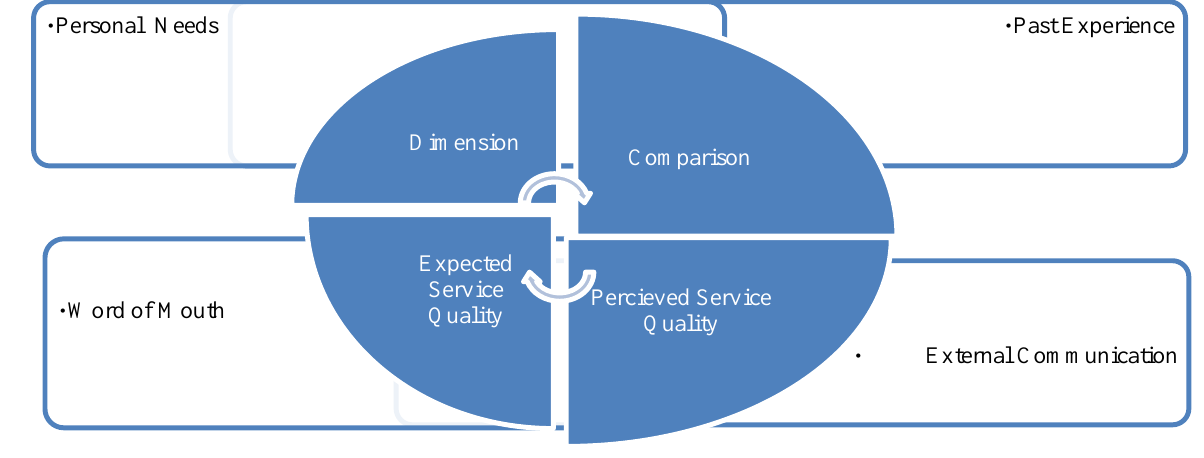
Fig. 1. Customer Assessment for service quality